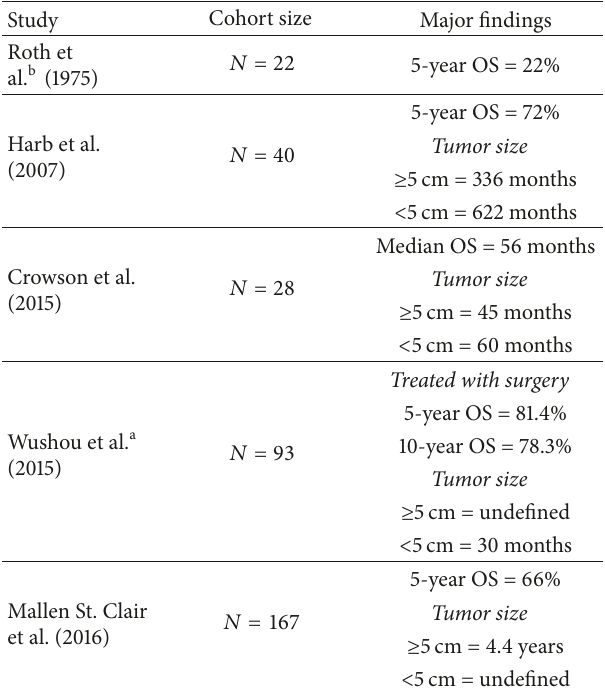
Table 4: Summary of overall and progression-free survival rates with other HNSS